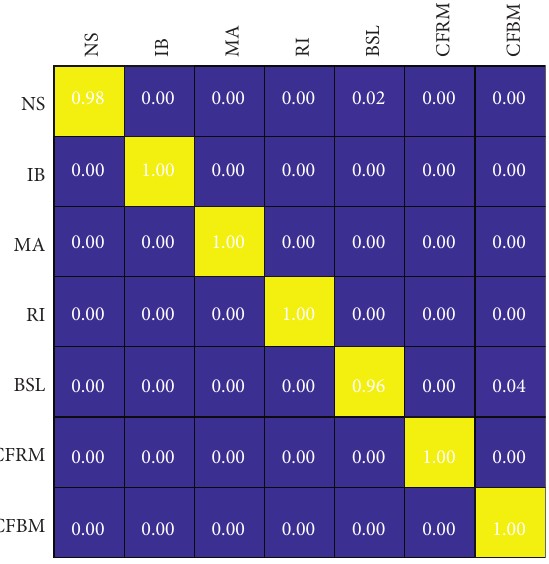
Figure 11: Classification result by the proposed method.